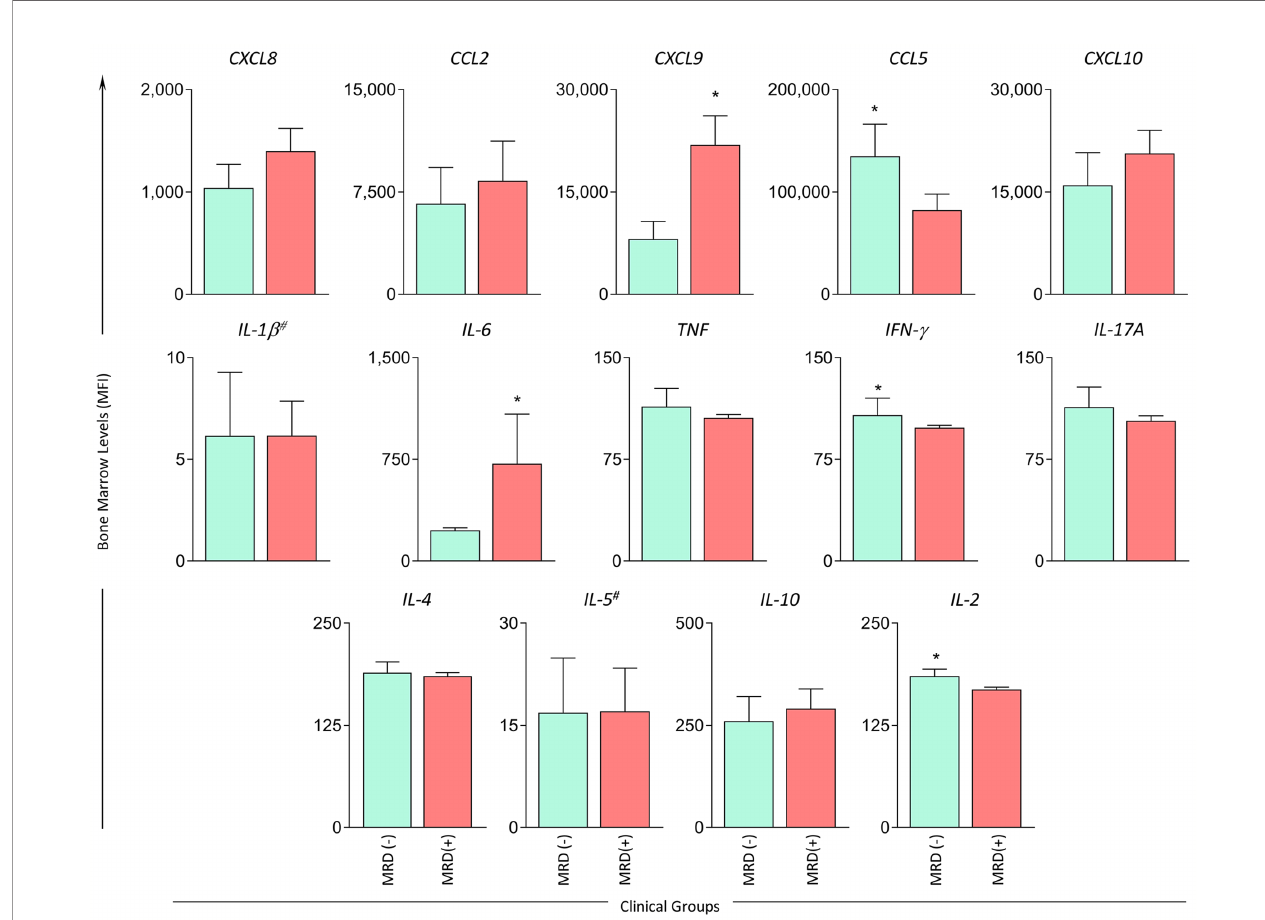
FIGURE 4 | Bone marrow soluble mediators in B-ALL patients according to the minimal residual disease detection on D35. The levels of bone marrow soluble mediators (CXCL8, CCL2, CXCL9, CCL5, CXCL10, IL-1 b # , IL-6, TNF, IFN- g , IL-17A, IL-4, IL-5 # IL-10, IL-2) were measured at baseline (D0) in B-ALL patients categorized according to minimal residual disease detection on D35 of induction therapy, denominated as MRD (-) ( ) and MRD (+) ( ) subgroups. Soluble mediators were quanti fi ed using CBA and ELISA (IL-1 b and IL-5) # assays as described in the Materials and Methods section. Data are reported as mean concentration ± standard error expressed in MFI or pg/mL (IL-1 b and IL-5). Statistical analyses were performed using the Student ’ s t test or Mann Whitney test and signi fi cant differences are underscored by asterisks for p<0.05